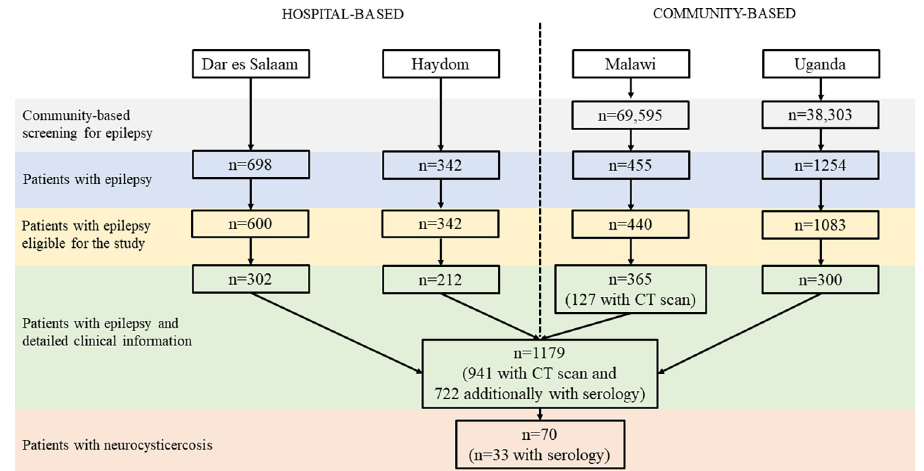
Fig 1. Flowchart of the patient selection by site y . y Detailed serological tests were available from the studies in Dar es Salaam, Malawi and Uganda.